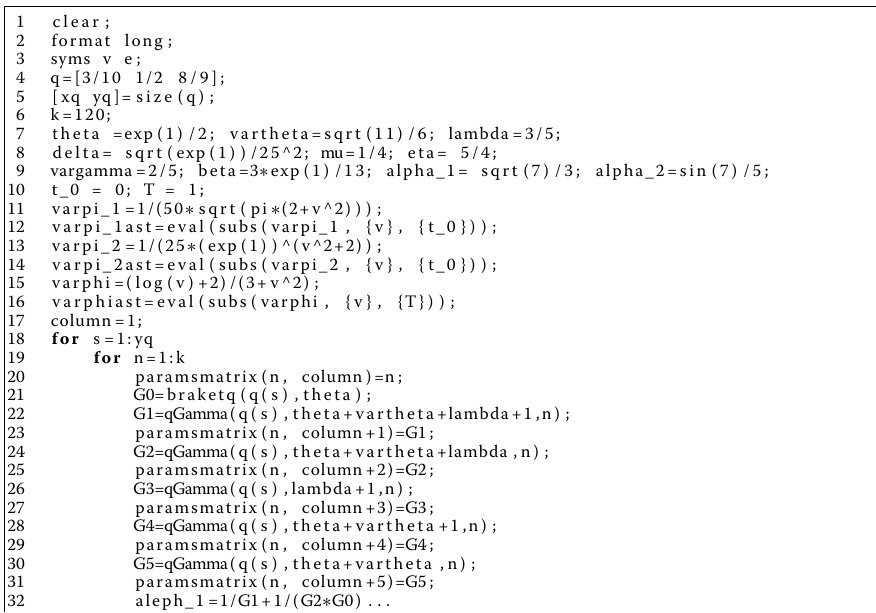
Algorithm 3 (MATLAB lines for calculation of all variables in Example